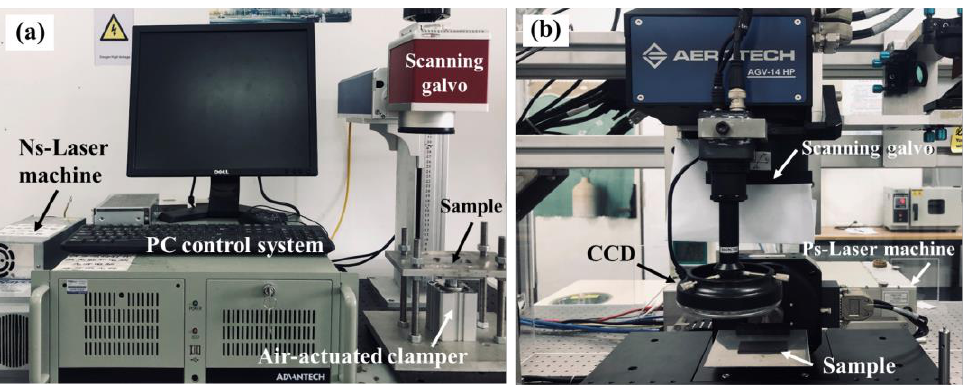
Figure 2. ( a ) Nanosecond laser machining system; ( b ) picosecond laser machining system [27].